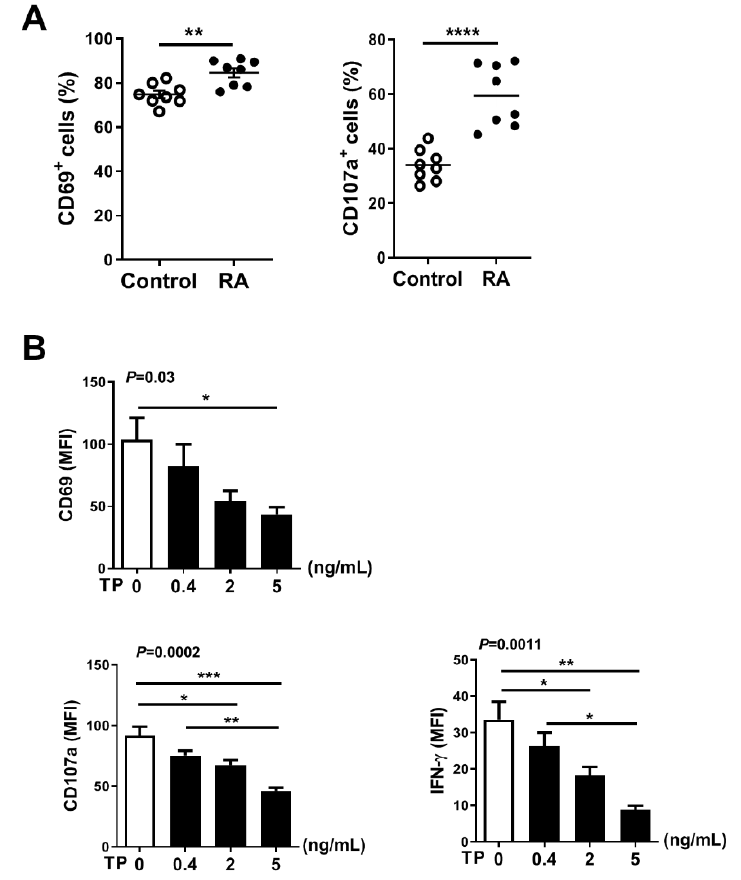
Figure 6. TP impairs NK cell function of rheumatoid arthritis patients without treatment. ( A ) From healthy donors and rheumatoid arthritis patients without any treatments, human PBMCs were isolated, respectively. The expression of CD69 was detected by flow cytometry in CD56+CD3 − cells. PBMCs were further co-cultured with K562 cells at a ratio of 2:1 (PBMC:K562 = 2:1), flow cytometric analysis of CD107a expression was carried out on CD56+CD3−cells. ( B ) PBMCs from rheumatoid arthritis patients were treated with TP as indicated (i.e., 0, 0.4, 2, 5 ng/mL) for 24 h, the expression of CD69, CD107a and IFN- γ were measured by flow cytometry in CD56+CD3−cells. Data were analyzed by unpaired t -test (( A ), n = 8) and one-way analysis of variance with a multiple comparisons test (( B ), n = 4), * p < 0.05, ** p < 0.01, *** p < 0.001, **** p < 0.0001.